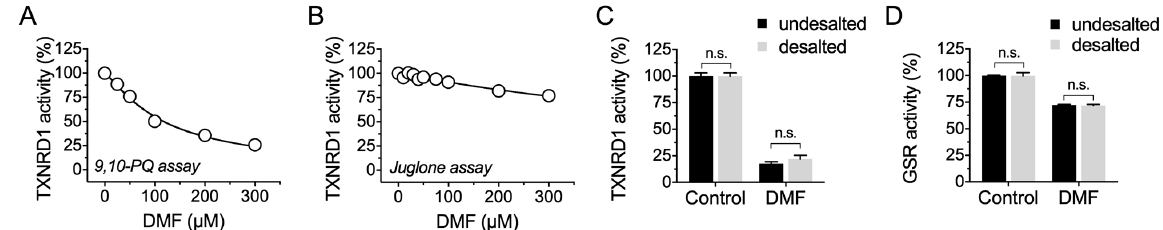
Figure 2. DMF irreversibly inhibits TXNRD1 activity but shows less inhibition on GSR. ( A , B ) Inhibition of 9,10-PQ and juglone reducing activity of TXNRD1 by DMF. Rat TXNRD1 (0.3 µ M) was treated with DMF for 1 h, and then the 9,10-PQ and juglone reducing activities were assayed, respectively. ( C ) Irreversible inhibition of DMF on TXNRD1. TXNRD1 was treated with 100 µ M DMF for 2 h and then desalted using NAP TM -5 desalting column. The residual TXNRD1 activity was measured by DTNB reducing activity. ( D ) Less inhibition of DMF on GSR. Yeast GSR was incubated with 500 µ M DMF for 2 h and then desalted using NAP TM -5 desalting column. The activity of GSR was determined in presence of 200 µ M NADPH by reducing GSSG. Data are presented as mean ± SEM with three independent experiments. n.s., not